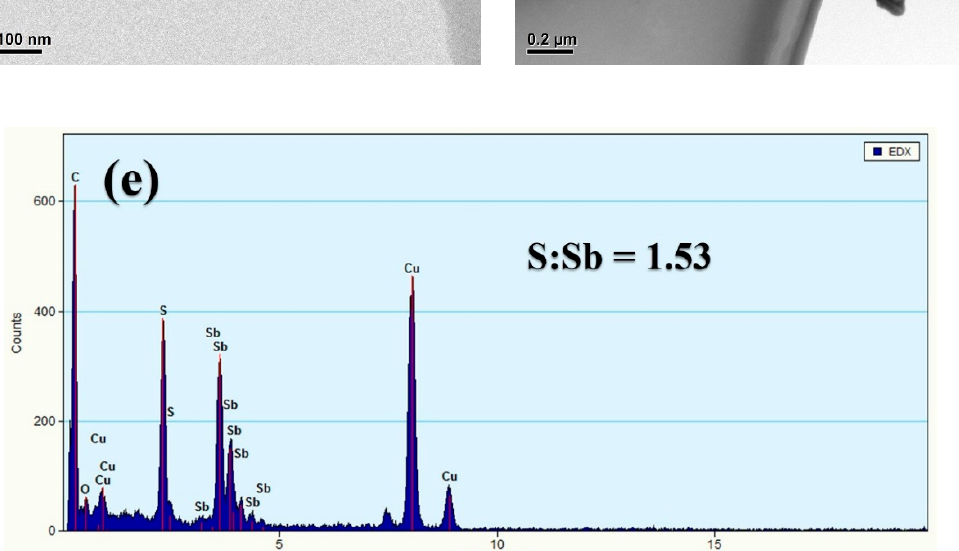
Figure 2. SEM and TEM images of the as-synthesized Sb 2 S 3 /CNT nanocomposites. ( a , b ) SEM images, ( c , d ) TEM images and ( e ) EDX spectrum. Selected-area electron diffraction (SAED) pattern is illustrated in ( d